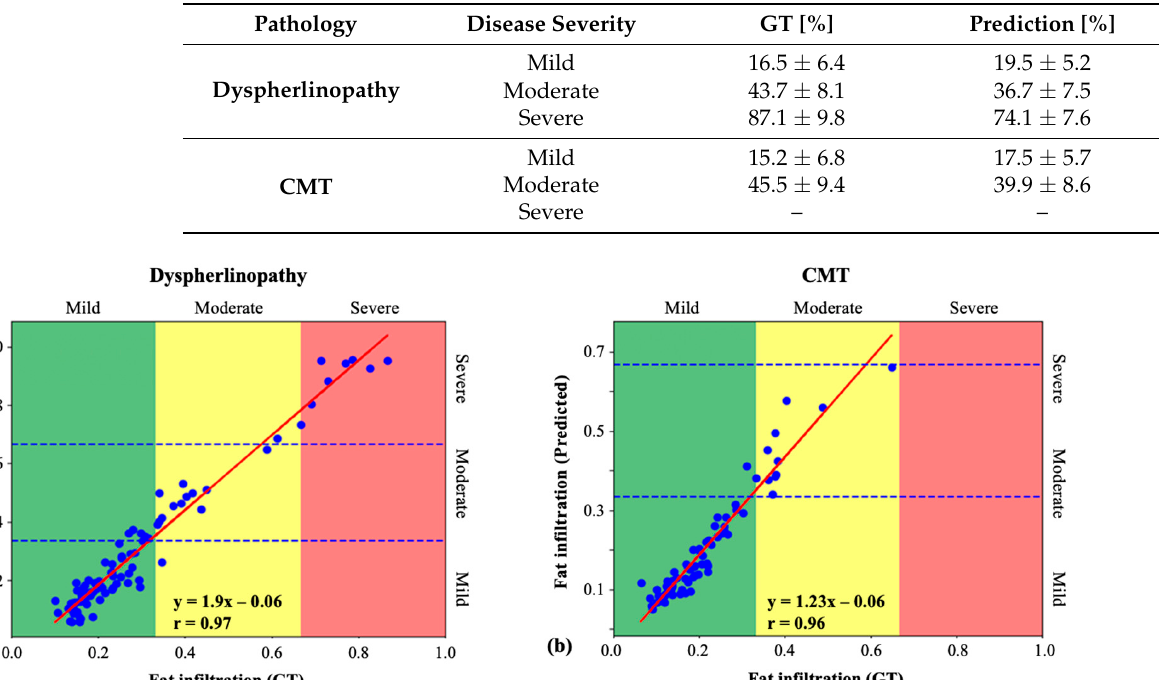
Figure 9. Linear regression of the IMAT fraction biomarker estimated from ground truth and using the suggested FCN technique: ( a ) dysferlinopathy patients’ data; ( b ) Charcot–Marie–Tooth (CMT) patients’